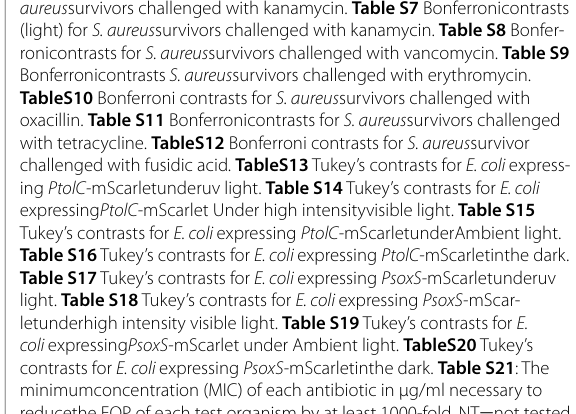
Table S16 Tukey’s contrasts for E. coli expressing PtolC- mScarletinthe dark. Table S17 Tukey’s contrasts for E. coli expressing PsoxS- mScarletunderuv light. Table S18 Tukey’s contrasts for E. coli expressing PsoxS- mScar- letunderhigh intensity visible light. Table S19 Tukey’s contrasts for